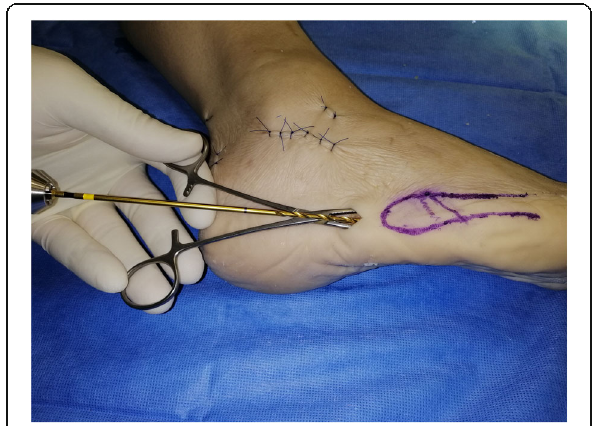
Fig. 5 The Fiberwire® is crossed subcutaneously, using small curved Klemmer forceps, from distal to proximal in a figure-of-eight pattern and looped around the neck of the screw. The dorsal wire is pulled plantarly and the plantar wire dorsally